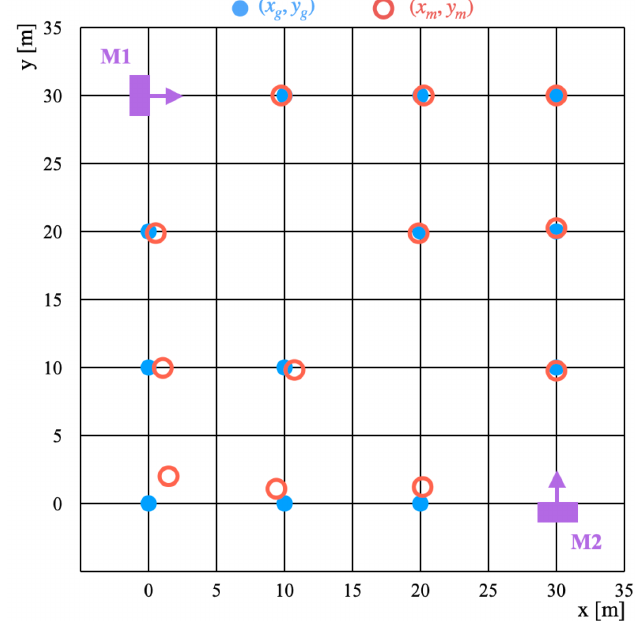
Figure 13. Positional distributions for the GT positions and estimated positions for Experiment A.